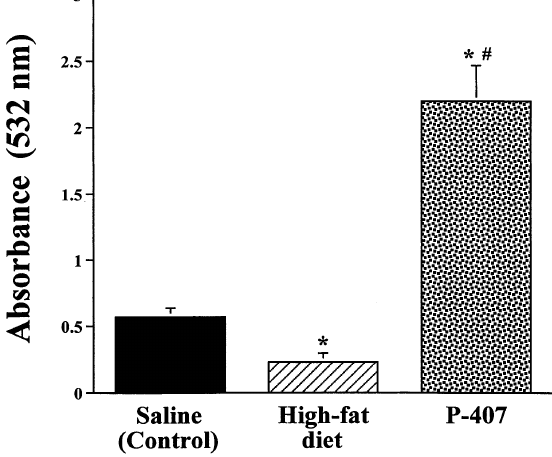
FIG. 5. The effect of a high-fat diet or P-407 treatment on the extent of lipid oxidation in C57BL/6 mice. All bars represent the mean value 9 / standard deviation (n (cid:4) / 6). * Significant (P B / 0.05) decrease (high-fat) or increase (P-407 treatment) in the mean absorbance value when individually compared with saline-treated controls. # Significant (p B / 0.05) increase compared with the mean absorbance value for mice that consumed the high-fat diet. The mean absorbance value for P-407-treated mice was obtained following a nine-fold dilu- tion of the plasma